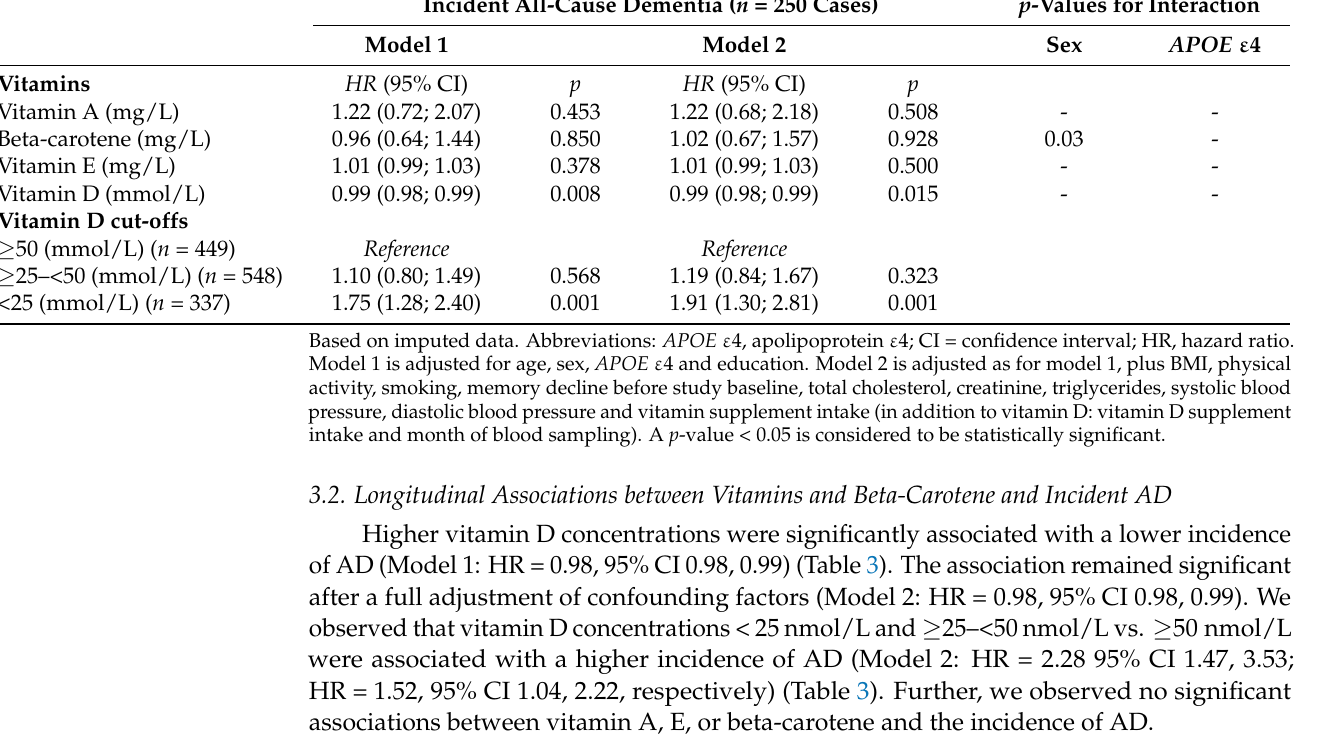
Table 2. Longitudinal associations between blood (serum/plasma) concentrations of vitamins A, D and E and beta-carotene and incident all-cause dementia over a 7-year follow-up period ( n = 1334). Incident All-Cause Dementia ( n = 250 Cases) p -Values for Interaction Model 1 Model 2 Sex APOE ε